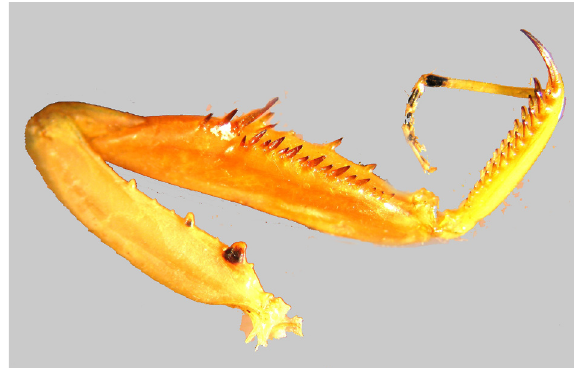
Image 6. Inner view of entire fore leg